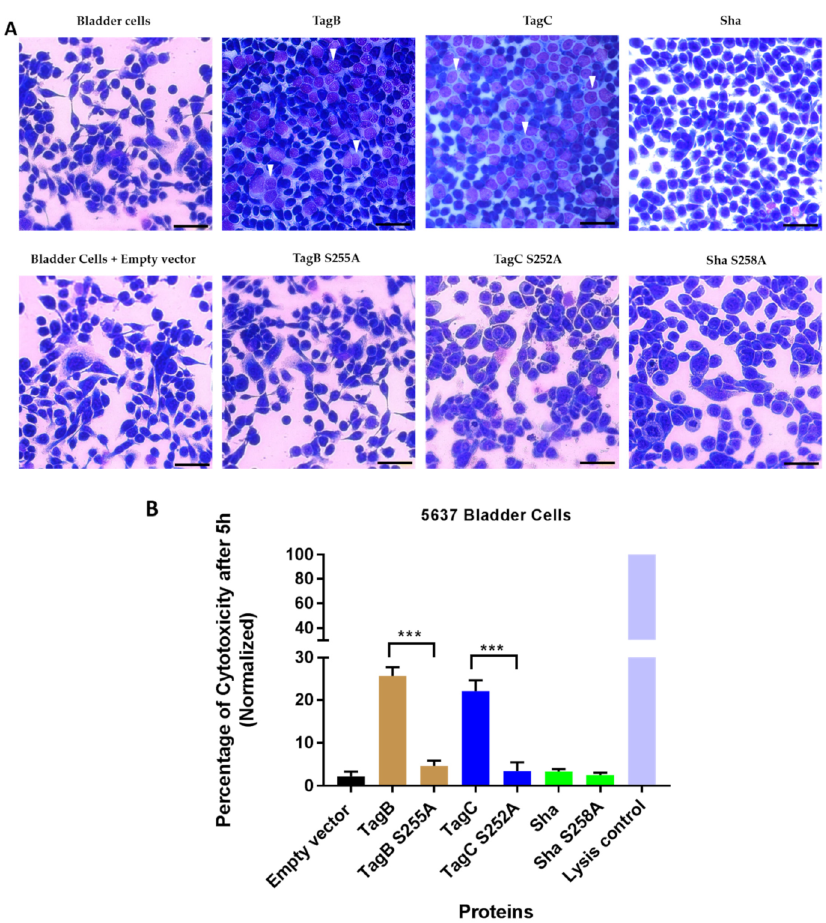
Figure 3. The serine catalytic site is necessary for the cytopathic effect of TagB and TagC. ( A ) Concentrated supernatants containing 30 µ g of protein per well derived from E. coli BL21 clones expressing TagB, TagC, Sha, or their respective serine mutant variant proteins were incubated with monolayers of the 5637 human bladder epithelial cell line for 5 h at 37 ◦ C. Cytopathic effects (white triangle) were absent in cells treated with the serine catalytic site mutant variants of TagB or TagC. The empty vector (pBCsk + ) without insert was used as a negative control. The scale bar represents 20 µ m. ( B ) Cytotoxicity measured by LDH release from 5637 human bladder cells after incubation with supernatant filtrates of different clones (30 µ g of protein per well) at 37 ◦ C for 5 h. Empty vector (pBCsk + ) was used as a negative control and maximum LDH release (positive control) was determined by treatment with lysis solution. Data are the means of three independent experiments, and error bars represent the standard errors of the means. Significant differences between lysis caused by native and mutant SPATEs were determined using Student’s t -test with *** p <